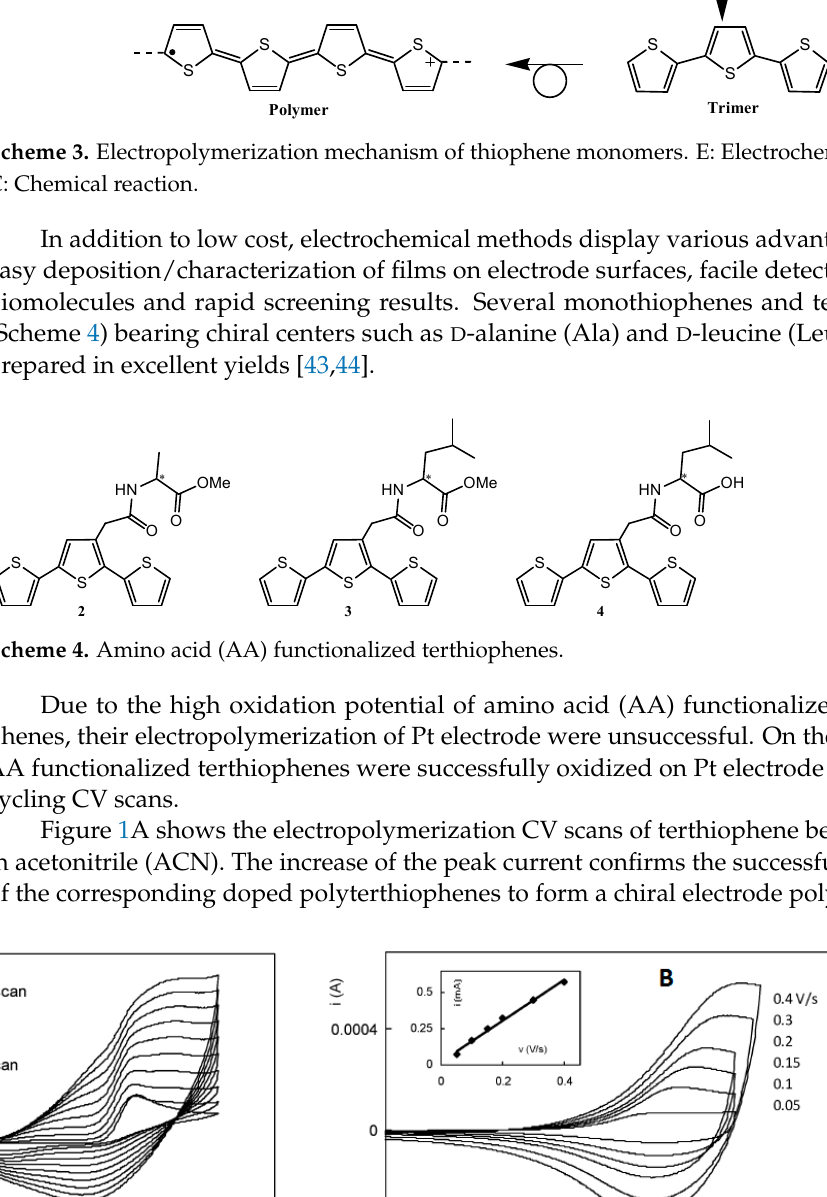
Figure 1. ( A ) The 10 scan electrochemical oxidation of terth-Ala-OMe (2) in ACN. (B ) poly2-Pt at different scan rates. Reprinted with permission from reference [43]. Copyright 2010 The Royal Society of Chemistry.